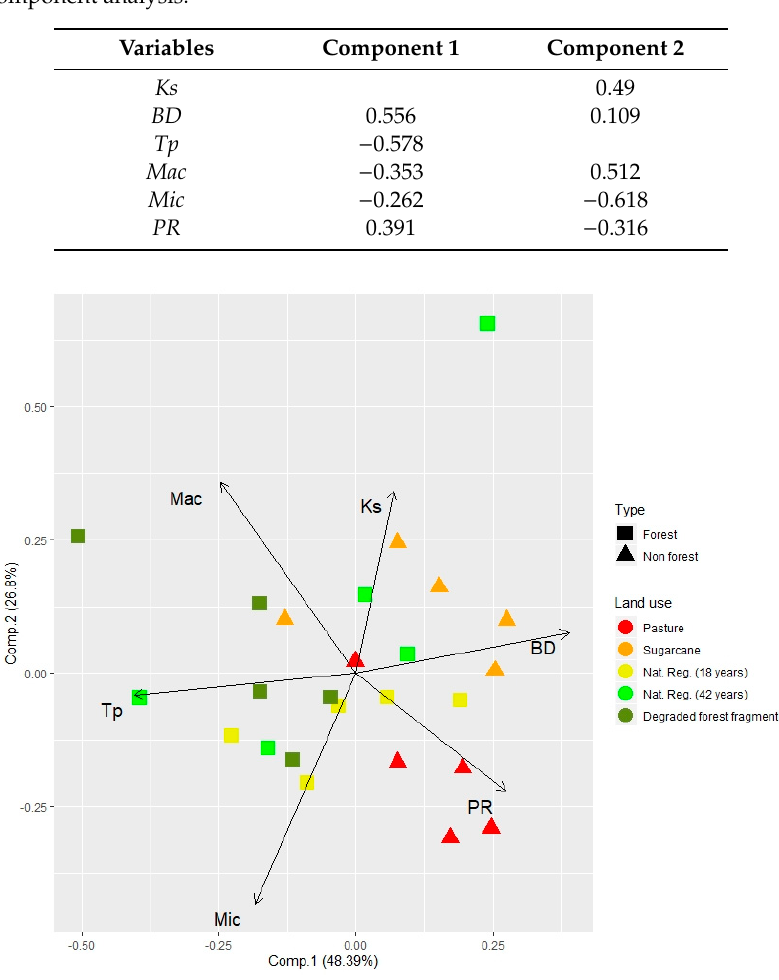
Figure 4. Principal Component Analysis (PCA) biplot based on soil attributes: Log Ks (mm h − 1 ), BD (g cm − 3 ), Tp (cm 3 cm − 3 ), Mic (cm 3 cm − 3 ), Mac (cm 3 cm − 3 ), PR (Mpa). Symbols represent plot sites for each land-cover type: Nat.Reg = natural regeneration.